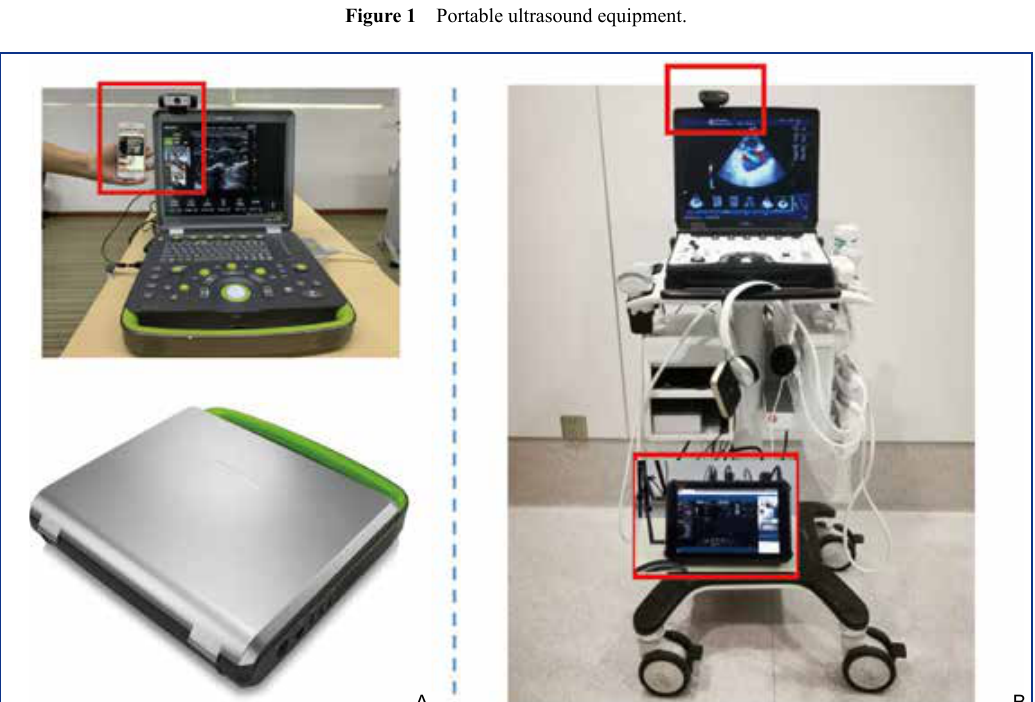
Figure 2 The two types of fifth generation (5G) teleultrasound systems in China: (A) built-in type: the the 5G technology is built into the ultrasound equipment (Clover, Wisonic , Shenzhen, China); (B) universal type: the 5G technology is independent of the ultrasound equipment (Keyi Information Technology Co., Ltd, Shanghai,